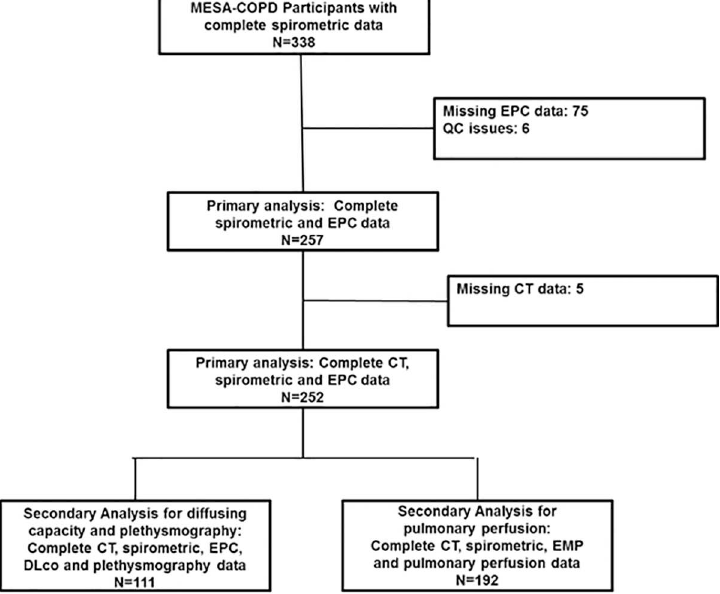
Fig 1. Flowchart of study participants. COPD = chronic obstructive pulmonary disease;CT = computed tomography; EMP = endothelial microparticle; MESA = Multi-Ethnic Study of Atherosclerosis.